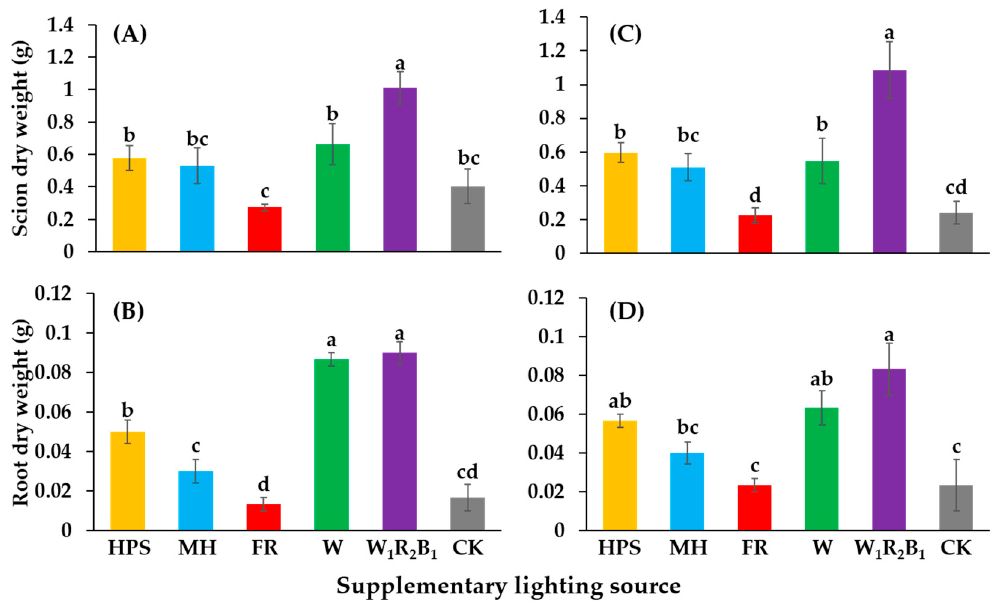
Figure 4. Effects of supplementary lighting on dry weights of the shoot and root of two tomato cultivars Super Sunload ( A , B ) and Super Dotaerang ( C , D ). The error bars represent the stand error ( n = 9). Different letters indicate differences between treatments (ANOVA and Duncan’s test, p ≤ 0.05).